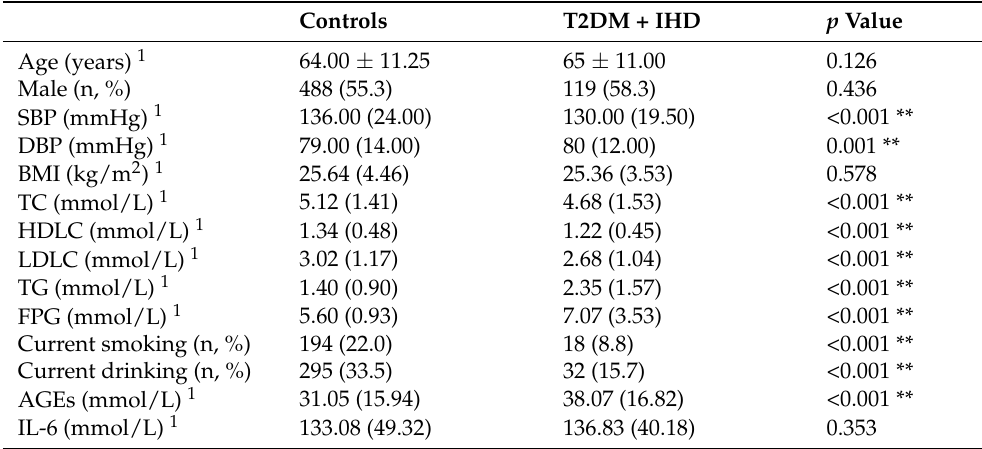
Table 1. Demographic and biochemical characteristics of the participants.